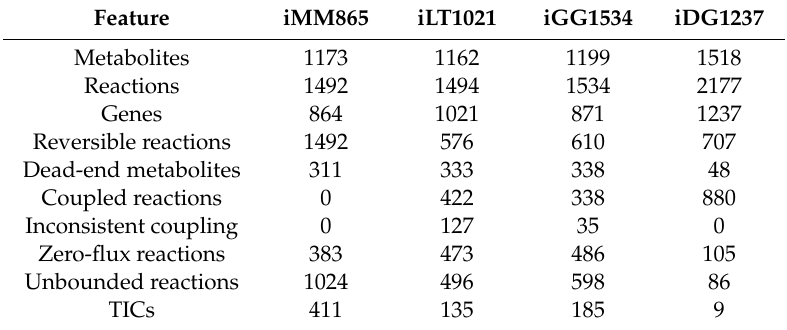
Table 1. Model consistency statistics of S. clavuligerus genome-scale metabolic